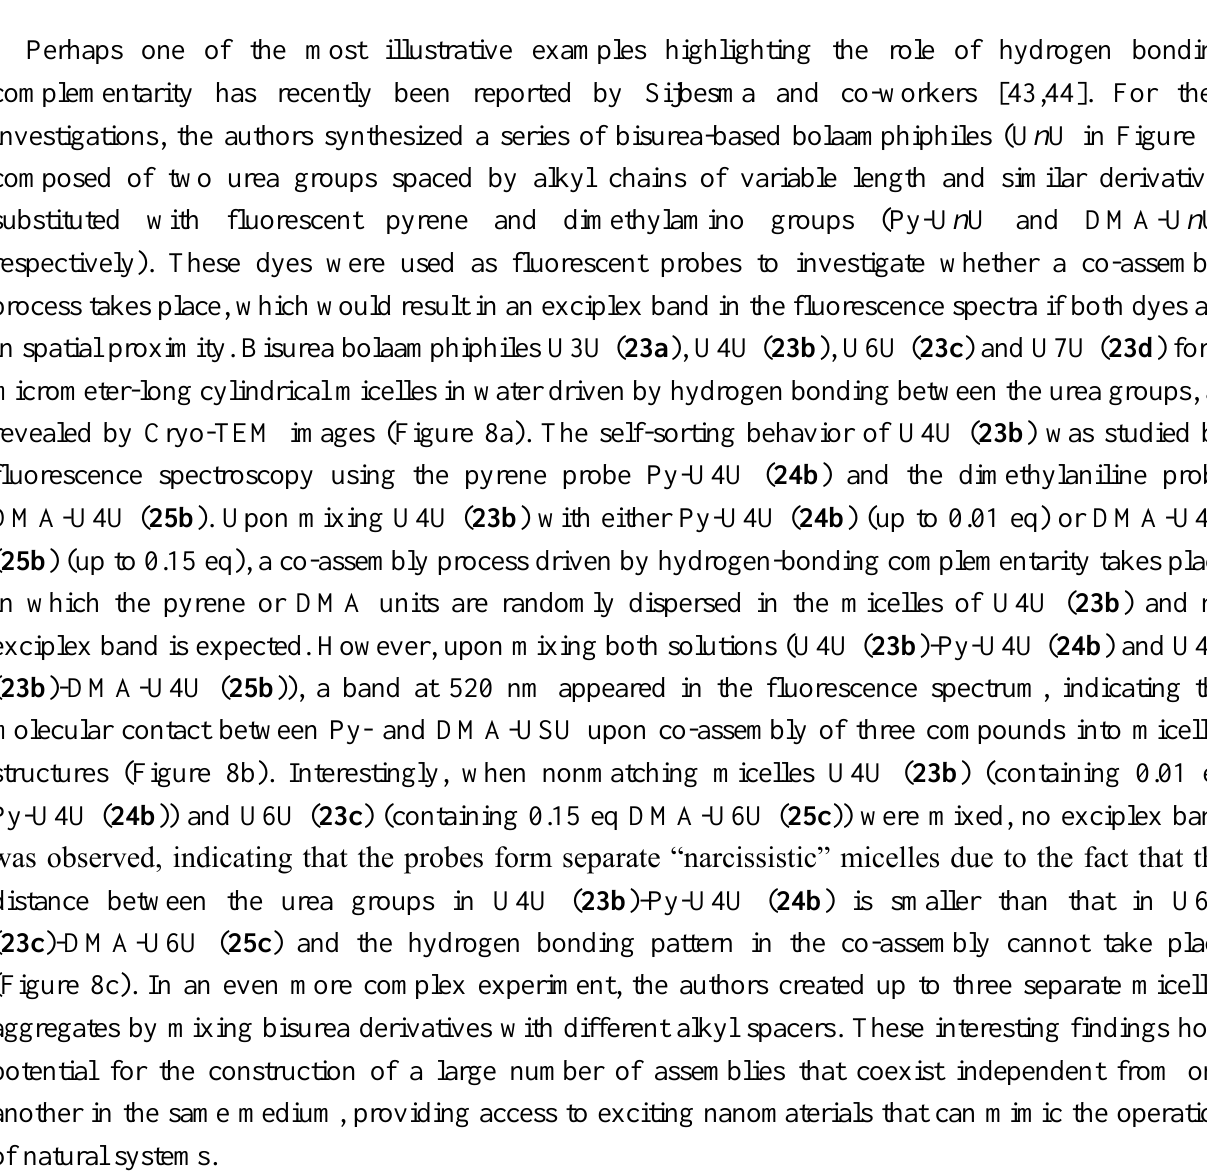
Figure 8. Molecular structures of U n U, Py-U n U and DMA-U n U derivatives ( 23 – 25 ). ( a ) Cryo TEM images of 1 wt% micellar solutions of U4U ( 23b ); ( b ) Intensity of